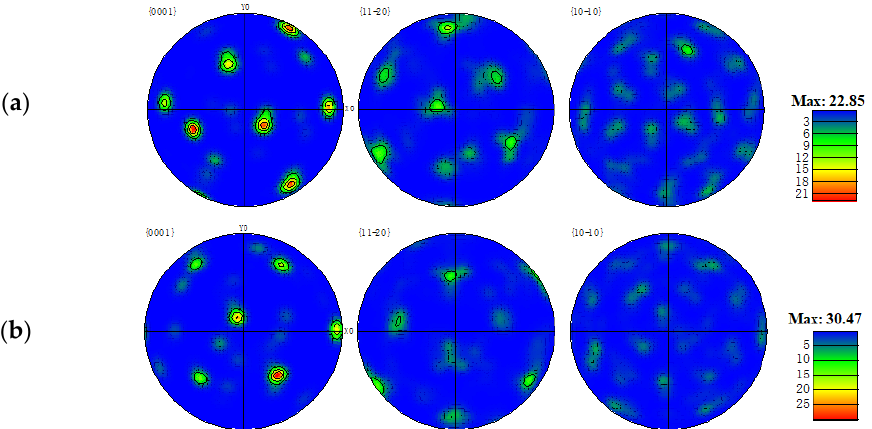
Figure 11. Comparison of textural orientation: ( a ) flux-cored wire welding joint; ( b ) cable wire welding joint.